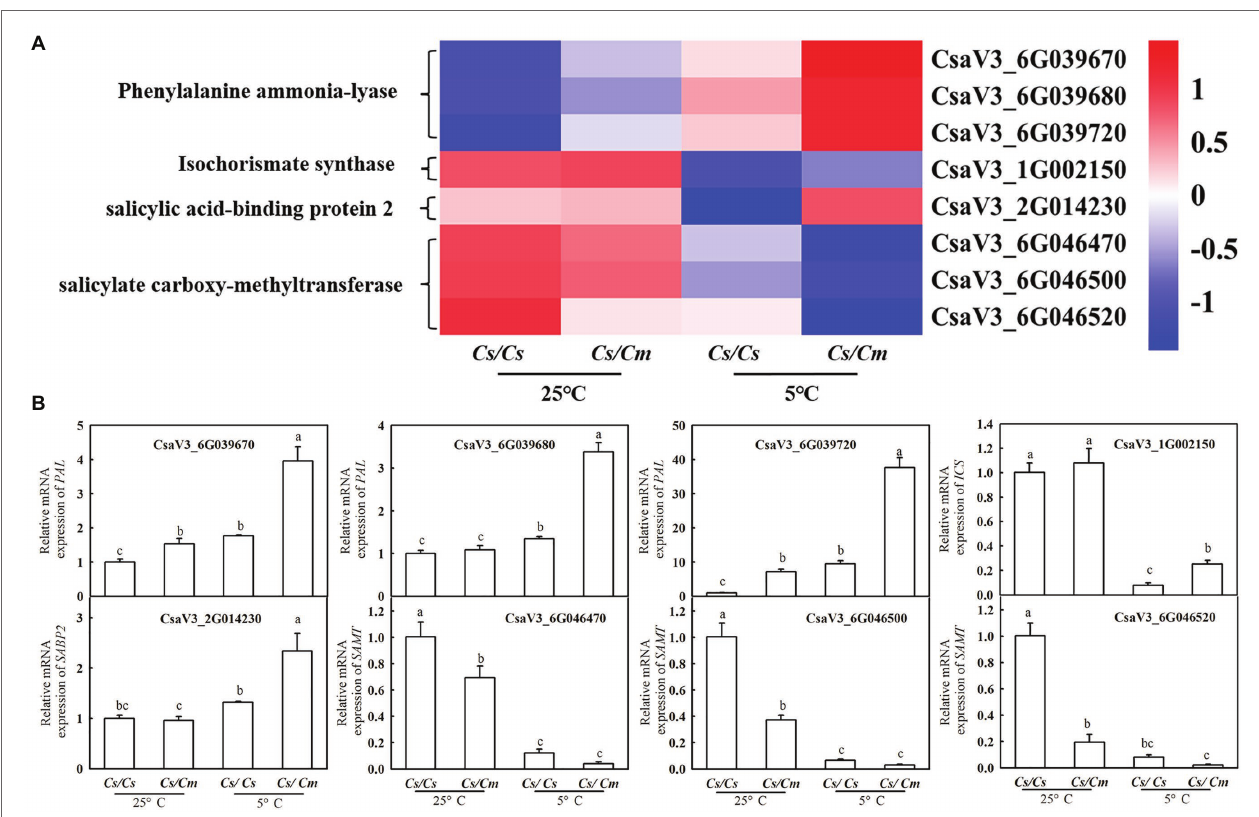
FIGURE 5 | Verification of RNA-seq results using qRT-PCR. (A) Hierarchical clustering analysis of transcriptome data; (B) relative mRNA expression of PAL , ICS , SAMT , and SABP2 in Cs/Cm and Cs/Cs leaves. Three-leaf stage seedlings were sampled at 12 h after chilling treatment. Data are the means of four replicates (±SDs). Different letters indicate a significant difference between samples according to Duncan’s new multiple range test ( p <